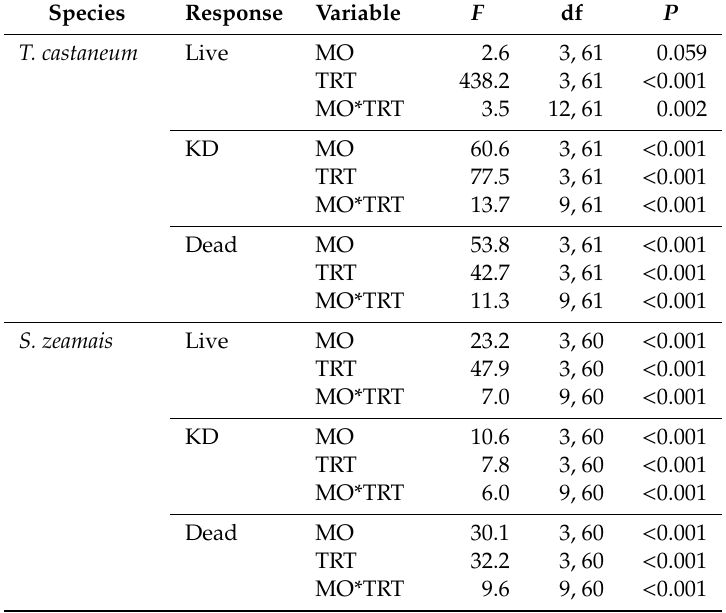
Table 6. ANOVA Table for main e ff ects month (MO), treatment (TR, untreated controls, two rates of Diacon IGR + , and the Gravista formulation for the percentage of adult T. castaneum and S. zeamais that were alive (Live), knocked down (KD), or dead (D) after 7 days of exposure on